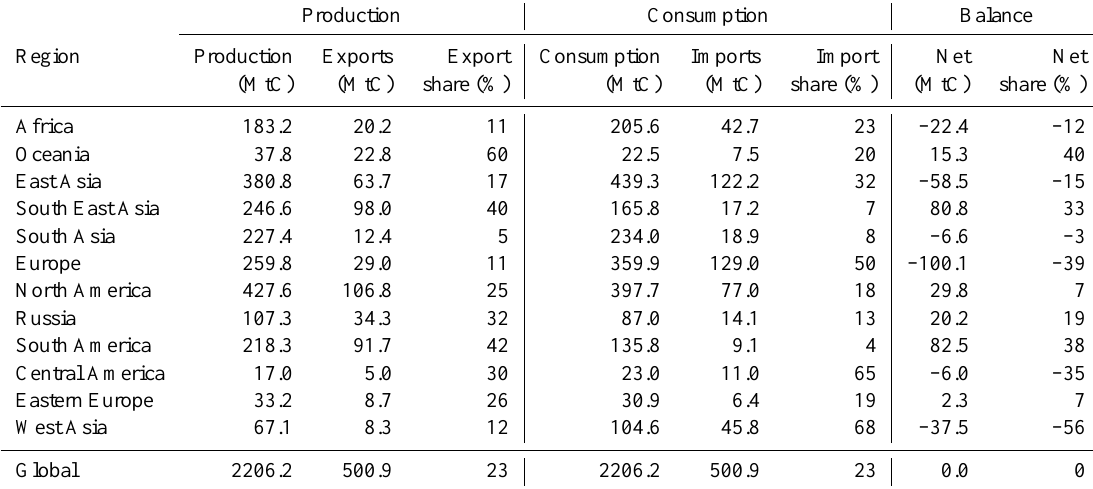
Table 13. The total biomass in carbon (HWPs, crops, livestock products) for production, consumption, exports, imports, and the balance (2004). All percentages are relative to the regional